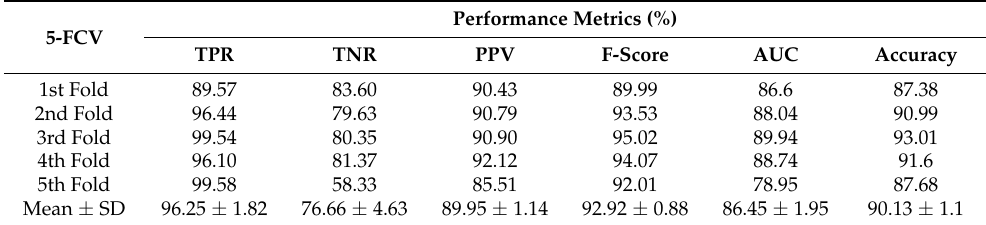
Table 9. Classification performance of the proposed model on Adadelta